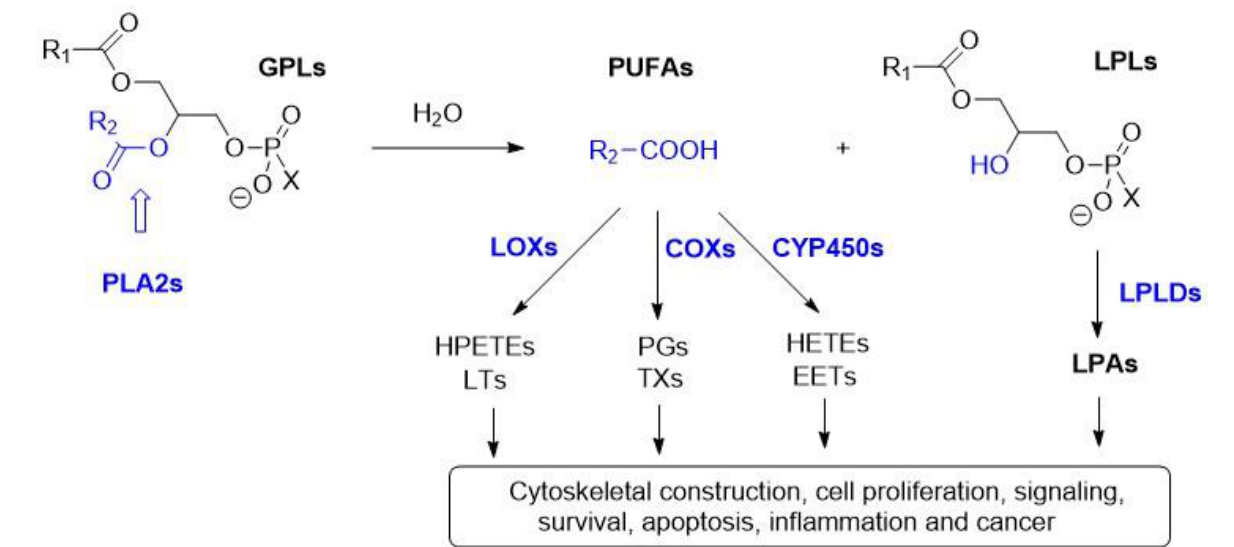
Figure 1. Schematic diagram of the fate of the phospholipids catalyzed by the PLA2s and further transformation into inflammatory mediators: PLA2s selectively hydrolyze the ester bond in sn-2 position of glycerophospholipids (GPLs) and release lysophospholipids (LPLs) and free fatty acids— mostly polyunsaturated fatty acids (PUFAs). PUFAs such as AA are metabolized by cyclooxygenases (COXs), lipoxygenases (LOXs) and cytochromes p450 (CYP450s) metabolic pathways into eicosanoids such as prostaglandins (PGs), thromboxanes (TXs), hydroperoxy-eicosatetraenoic acids (HPETEs), leukotrienes (LTs), hydroxy-eicosatetraenoic acids (HETEs) and epoxyeicosatrienoic acids (EETs). The LPLs can be further hydrolyzed by lysophospholipases D (LPLDs) into lysophosphatidic acids (LPAs)